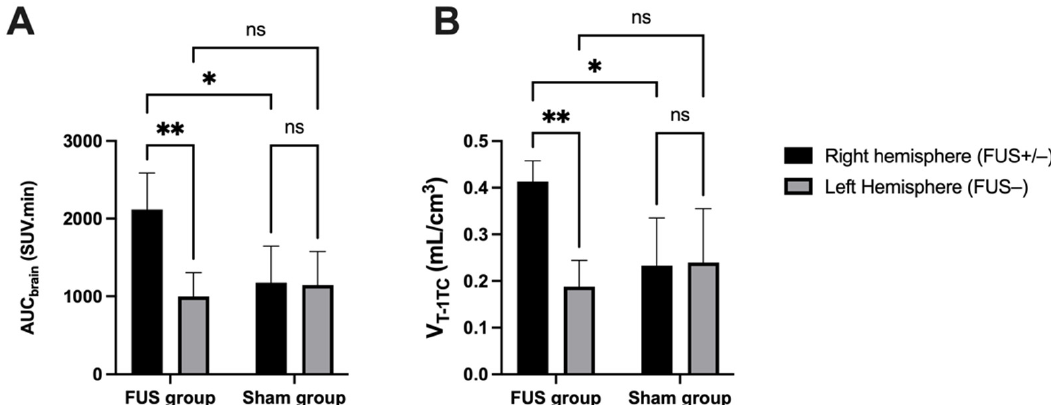
Figure 4. Comparison of [ 18 F]FDS brain PET data. Ultrasound-induced BBB disruption (FUS+) was obtained in the right brain hemisphere of the FUS group ( n = 5) while BBB in the contralateral brain hemisphere was intact (FUS − ). The brain exposure of [ 18 F]FDS was estimated by the area under the time-activity curve (AUC brain , in ( A ). Brain distribution was estimated by V T - 1TC (1-tissue compartment model, in ( B ) using an image-derived input function. Data were also compared with a sham group (no FUS, n = 3). Data are reported as mean ± S.D with * p < 0.05 and ** p < 0.01.